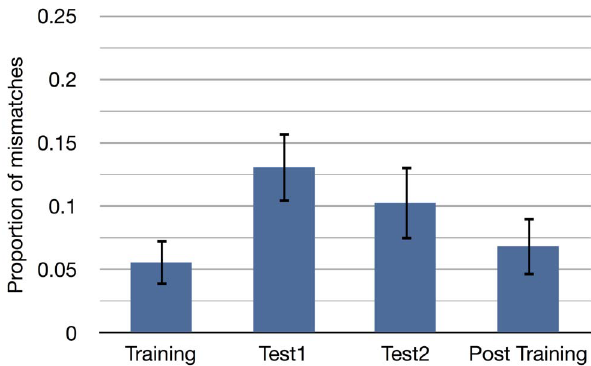
Table 2. Decoding results.